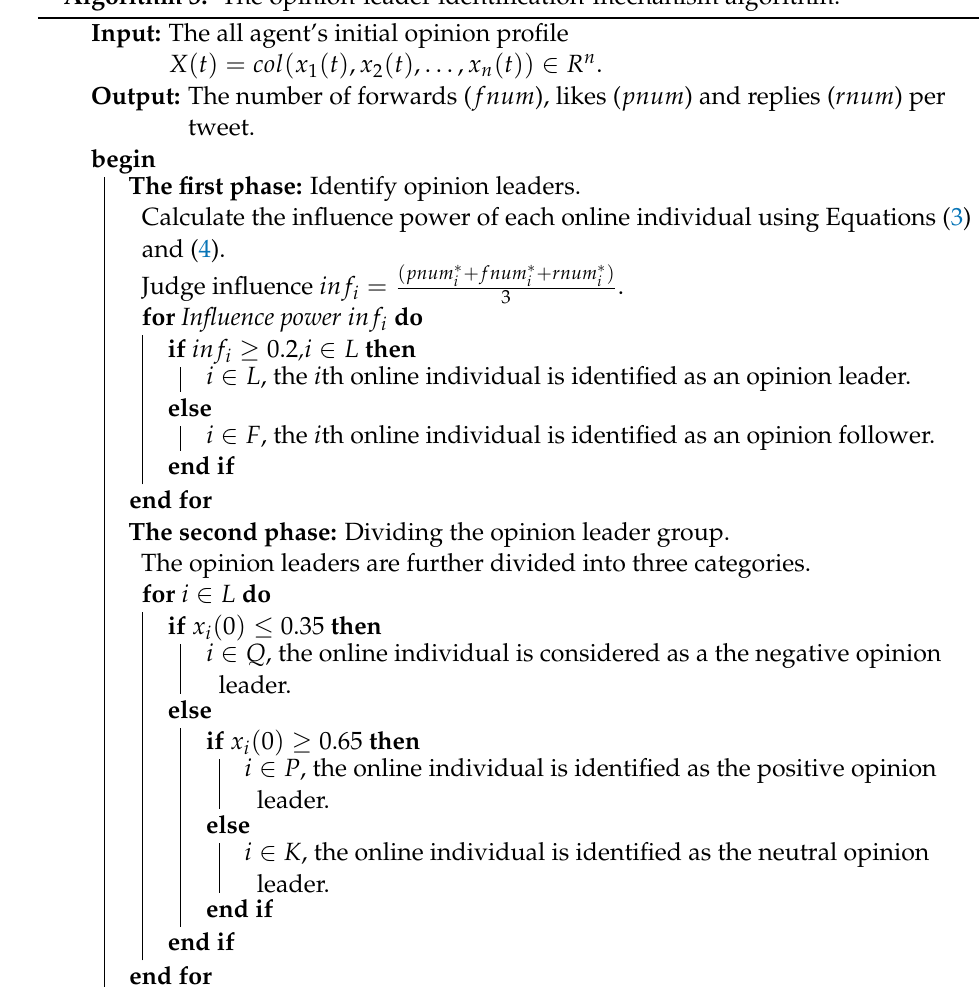
Algorithm 3: The opinion-leader identification-mechanism